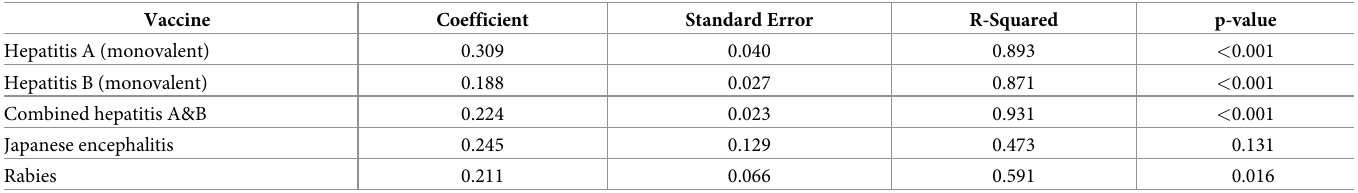
Table 3. Regression results for association between completion of vaccine series and proportion of registered pharmacists with authorization to administer injections. Vaccine Coefficient Standard Error